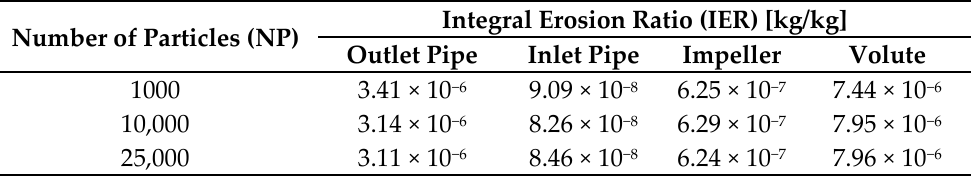
Table 2. Integral Erosion Ratio (IER) estimation at varying the Number of Particles (NP) (2.5 M mesh resolution, MRF approach).